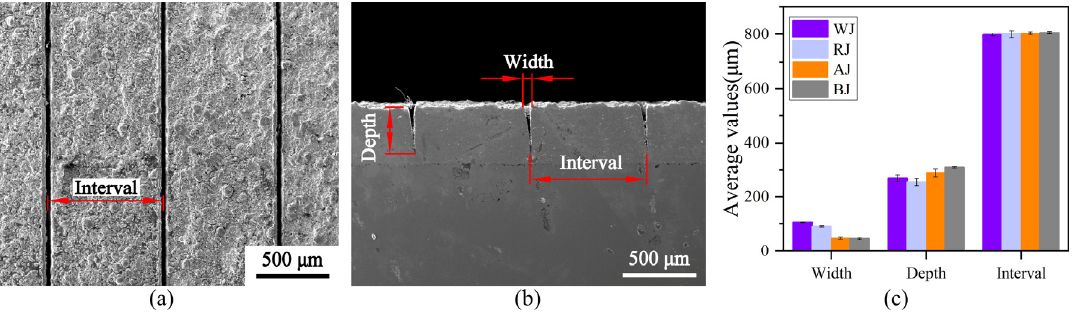
Figure 5. The interval ( a ), cross-section ( b ) and dimensions ( c ) of grooves fabricated via LST process.